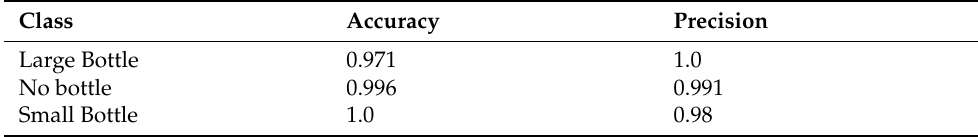
Table 2. Precision and accuracy for each